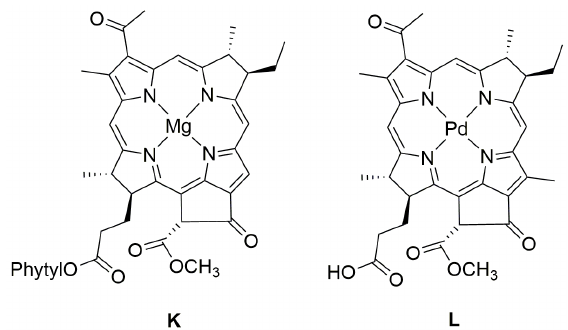
Figure 11 - Structures of bacteriochlorophyll a ( K ) and Tookad ( L ).